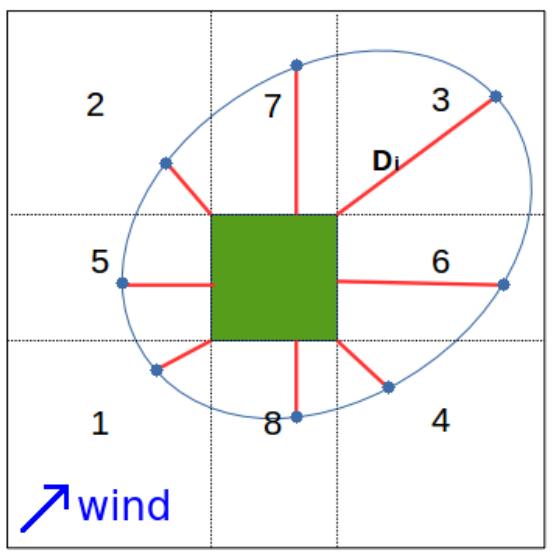
Figure 3. Zoning (dashed lines and numbers) and example of calculation (red lines) used to calculate the distance between any point on the 34 °C isoline and the park boundary.